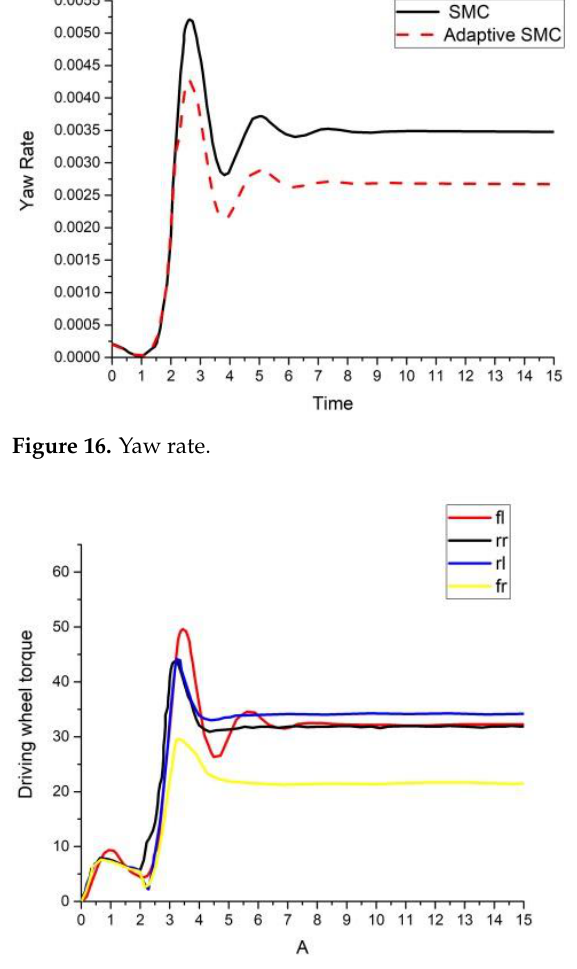
Figure 17. Driving wheel torque.